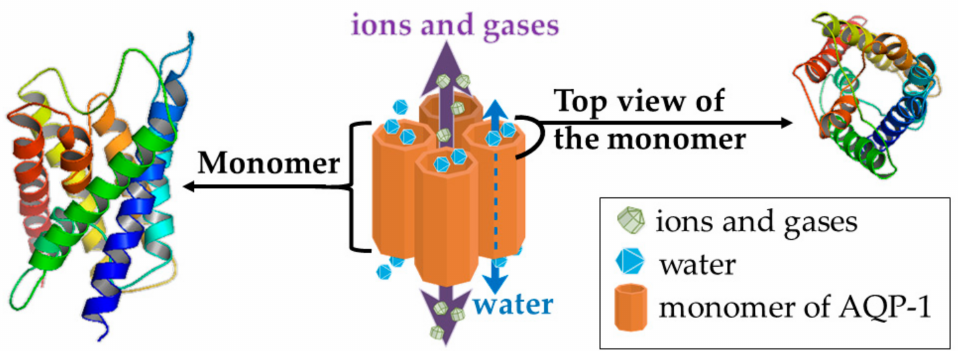
Figure 4. The structure of AQP1 channel, as a homotetramer, with the dashed arrow showing the water passage through the water channel of each monomer. The solid violet arrow represents the passage of ions and gases. The 3D structures were prepared in PyMol, version 1.7.4.5 (Schrödinger, Inc, Tokyo,